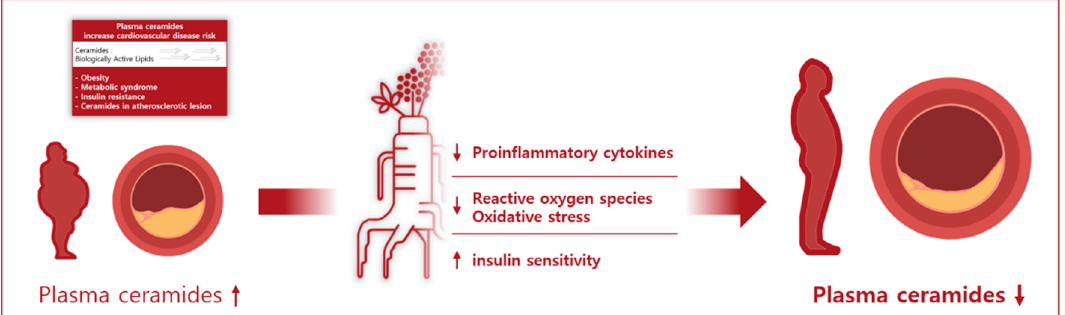
Figure 2. Schematic overview of Korean red ginseng’s effects on plasma ceramides.